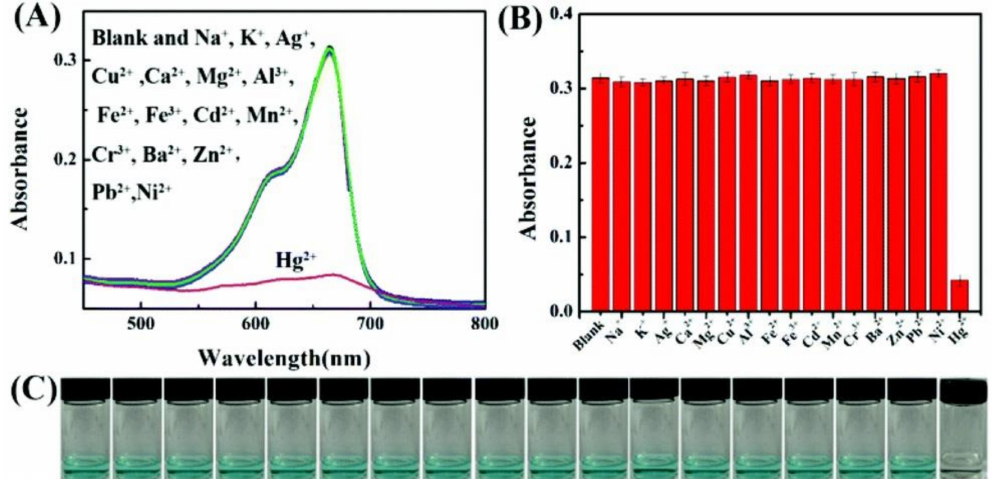
Figure 7. Selectivity of the sensing method by AuNP@MOF to other metal ions. Concentrations of Hg 2+ and other metal ions (Na + , K + , Ag + , Ca 2+ , Mg 2+ , Cu 2+ , Al 3+ , Fe 3+ , Fe 2+ , Cd 2+ , Mn 2+ , Cr 3+ , Ba 2+ , Zn 2+ , Pb 2+ and Ni 2+ ) were 1 nM and 10 nM, respectively. ( A ) The UV spectra of the sensing system in response to various metal ions; ( B ) The UV absorbance of the sensing system at 665 nm towards various metal ions; ( C ) photographs of the sensing system responding to various metal ions (Reproduced with the permission from Ref